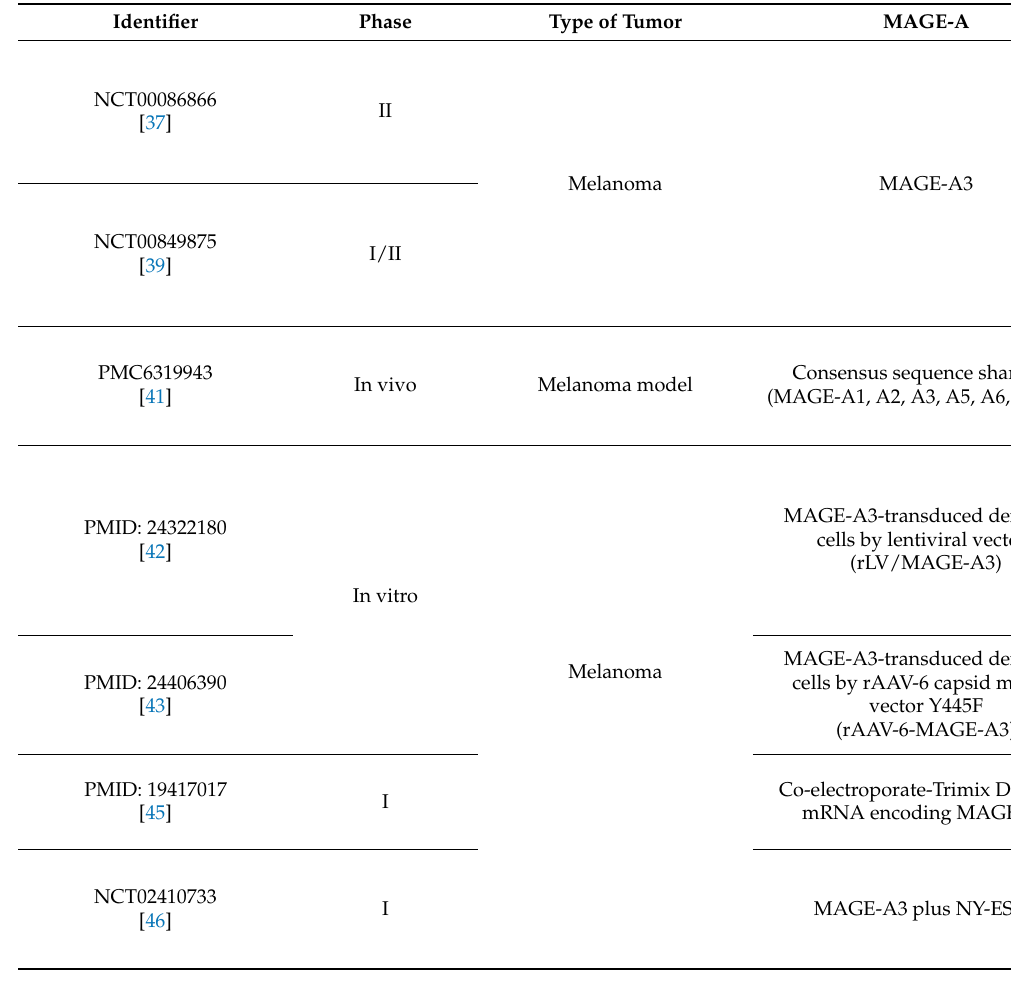
Table 1. An overview of MAGE-A-related preclinical and clinical